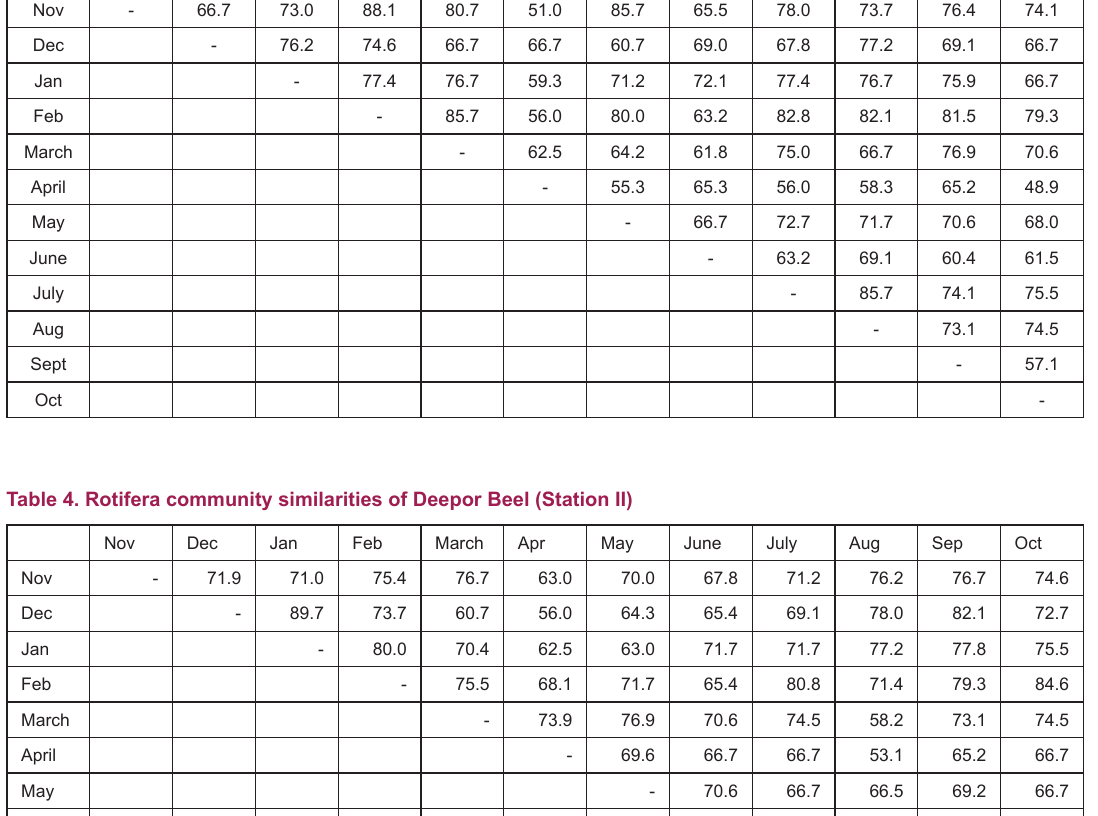
Table 3. Rotifera community similarities of Deepor Beel (Station I)